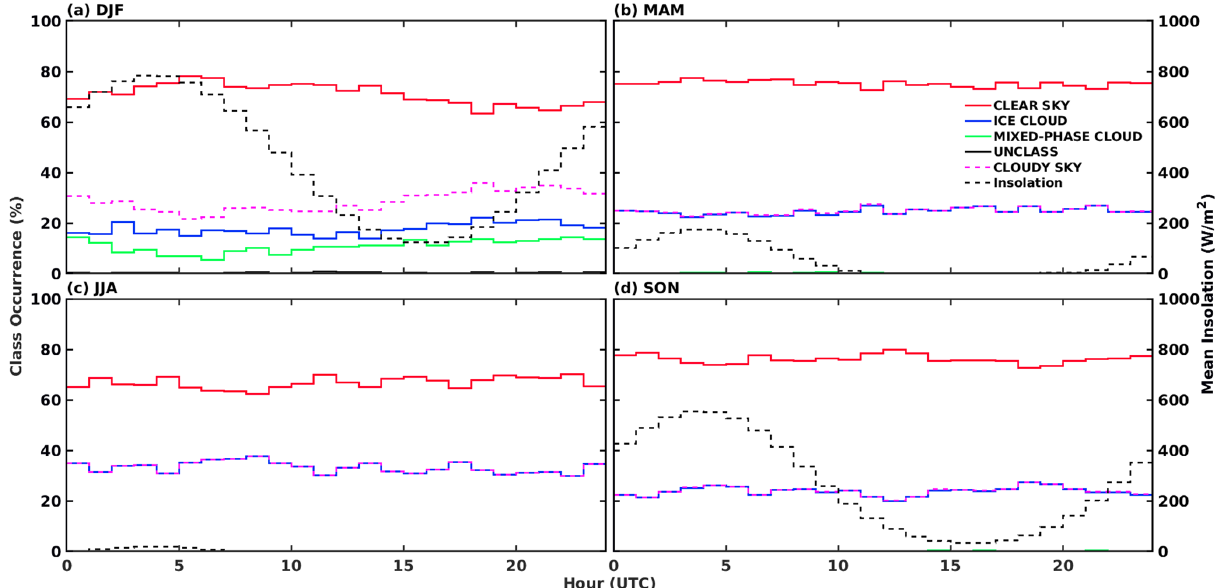
Figure 11. Hourly mean cloud occurrence of clear sky (red lines), ice clouds (blue lines), and mixed-phase clouds (green line). Unclassified spectra are in black and total cloud occurrence in magenta. Percentages of occurrence are provided for each season: (a) DJF, (b) MAM, (c) JJA, and (d) SON. The top of the atmosphere hourly mean insolation is also reported in Wm − 2 (dashed black line), referring to values reported on the right ordinate axis. Local time is UTC + 8.